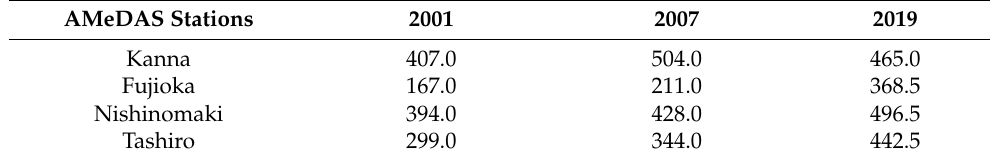
Figure 2. Kanna, Fujioka, Nishinoki, and Tashiro AMeDAS stations in Gunma Prefecture. Table 1. Cumulative rainfall (mm). AMeDAS